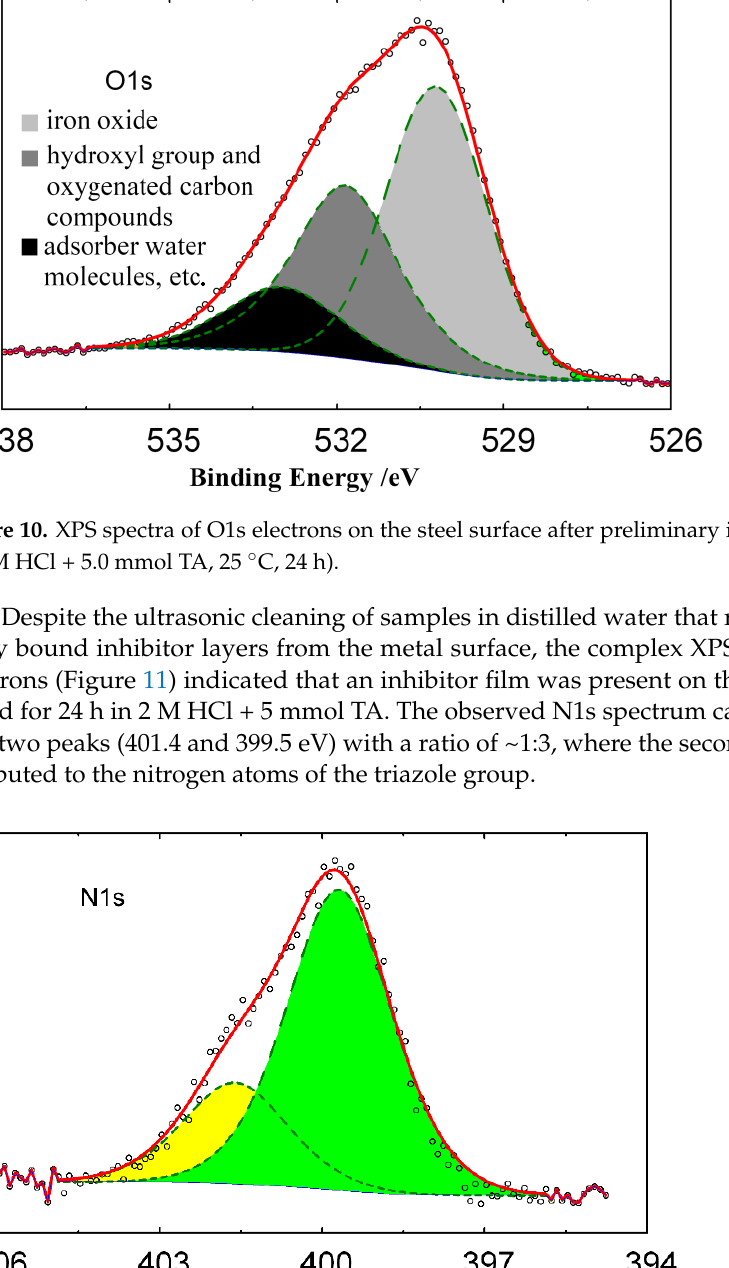
Figure 11. XPS spectra of N1s electrons on the steel surface after preliminary inhibitor adsorption (2.0 M HCl + 5.0 mmol TA, 25 °C, 24 h) followed by washing in an ultrasonic